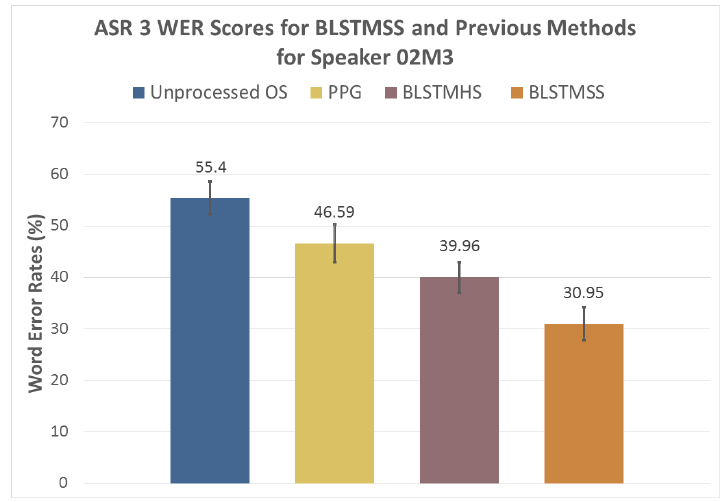
Figure 5. WER scores for Unprocessed OS, previous systems (PPG and BLSTMHS) and the proposed BLSTMSS system as calculated by ASR 3 for speaker 02M3. Error bars show standard errors.